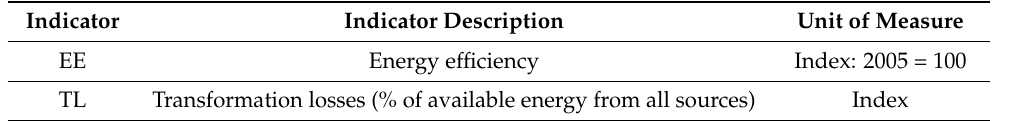
Table 1. The input variables of the model. Indicator Indicator